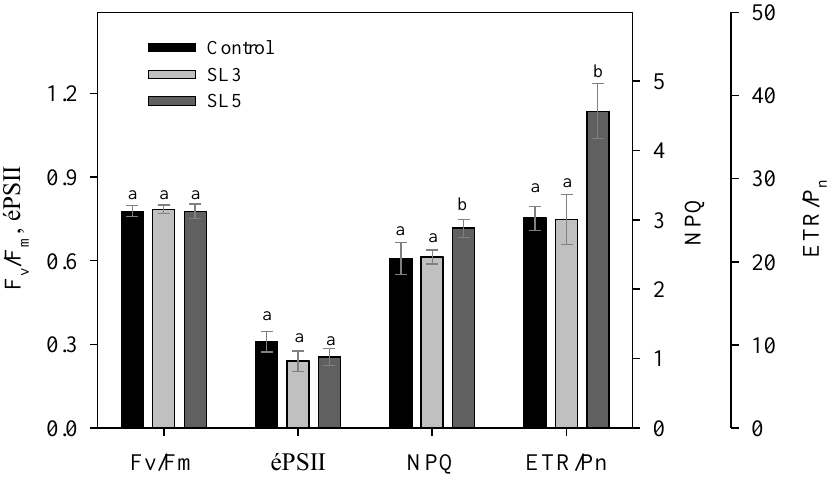
Figure 6. Effect of irrigation water salinity on chlorophyll fluorescence parameters of Hebe leaves at the end of the experiment. Maximum quantum yield of photosystem II (PSII) (F v /F m ), effective quantum yield ( é PSII), non-photochemical quenching (NPQ), and the ratio of electron transport rate to photosynthesis rate (ETR/P n ). Control (1.8 dS m − 1 , black), SL3 (3.3 dS m − 1 , light grey), and SL5 (4.9 dS m − 1 , dark grey). Values are means ( n = 6) and vertical bars indicate ± standard error. Different letters indicate statistically significant differences between means at p < 0.05 according to the least significant difference (LSD) test.